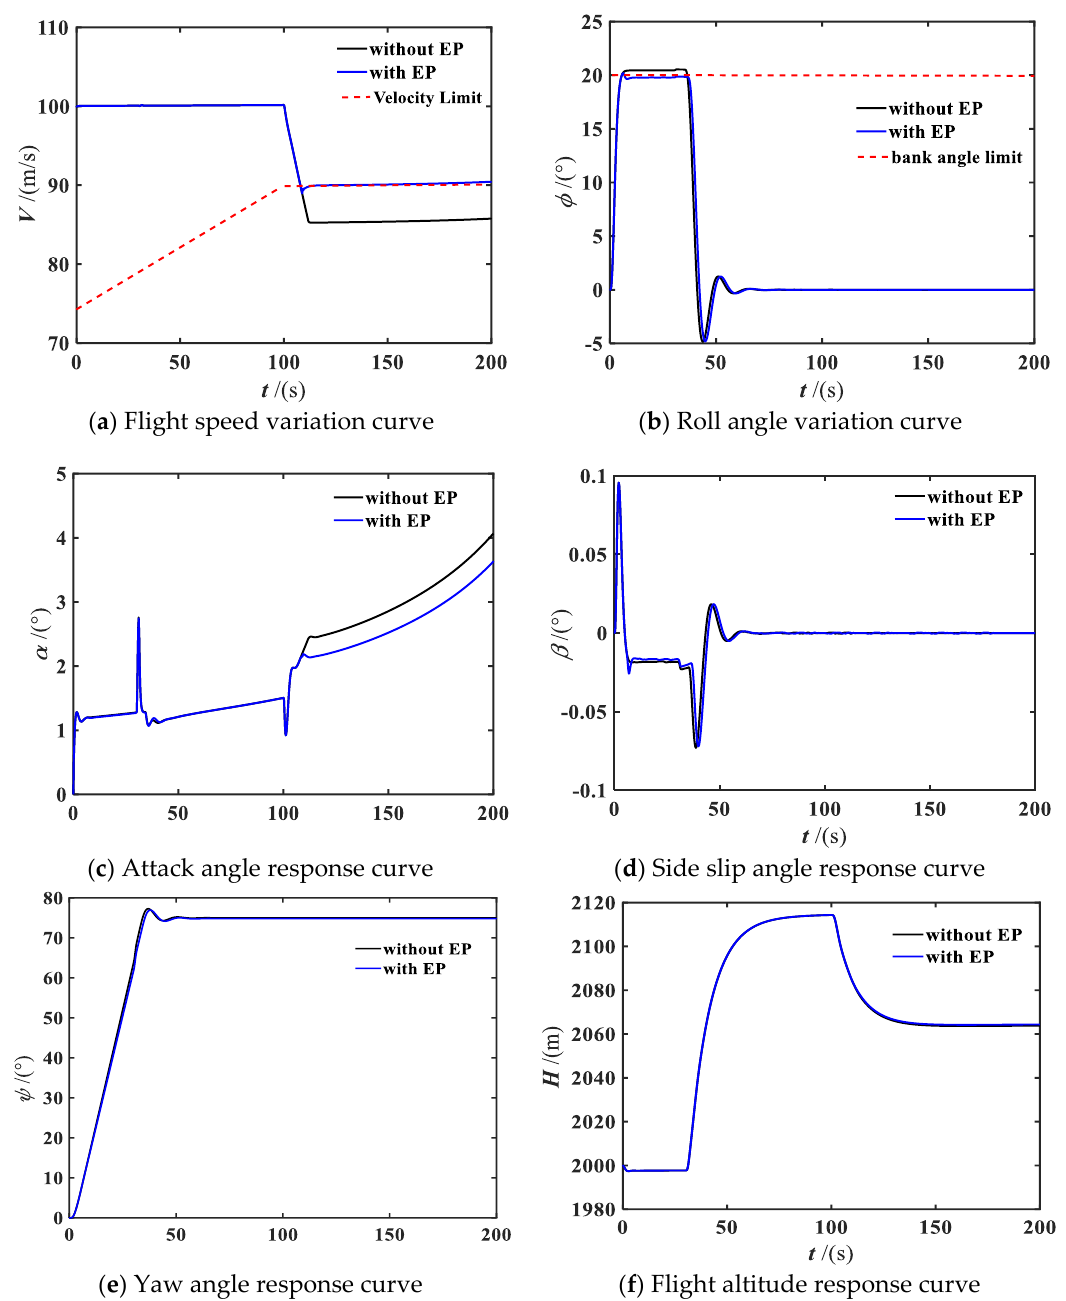
Figure 9. Dynamic response of aircraft under envelope protection based on L 1 adaptive stability augmentation control. ( a ) Flight speed variation curve. ( b ) Roll angle variation curve. ( c ) Attack angle response curve. ( d ) Side slip angle response curve. ( e ) Yaw angle response curve. ( f ) Flight altitude response curve.